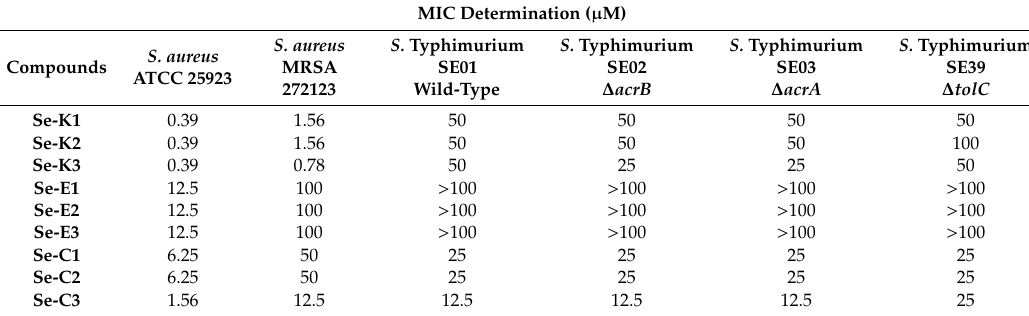
Table 1. Antibacterial activity of selenocompounds. Minimum inhibitory concentrations (MICs) of compounds were determined on reference Staphylococcus aureus ATCC (American Type Culture Collection) 25923 and methicillin and ofloxacin-resistant S. aureus 272123 (MRSA) strains and